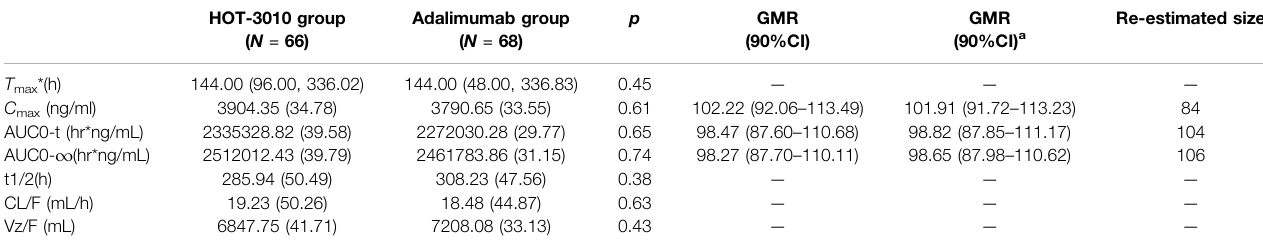
TABLE 3 | ADA and Nab positive rates n (%) after subcutaneous injection of HOT-3010 or adalimumab. Time (day)